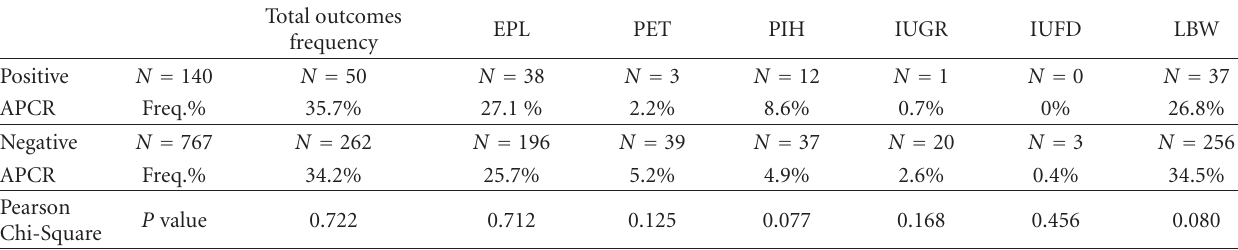
Table 4: Frequency of adverse outcomes identified in positive APCR (acquired plus inherited) versus negative APCR. P value from Pearson Chi-Square test applied to positive APCR (acquired plus inherited) versus negative APCR.